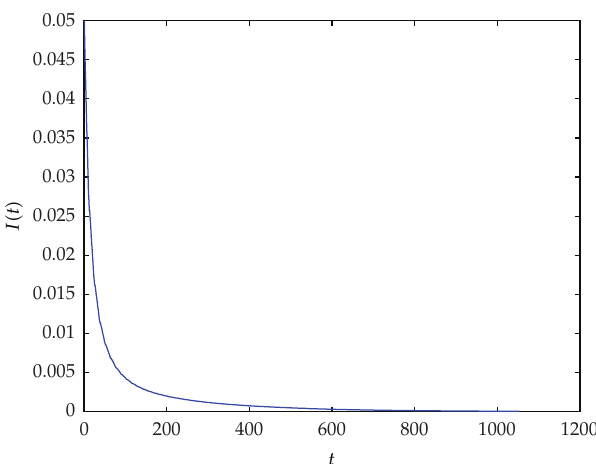
Figure 14: Time series of I (cid:3) t (cid:4) with parameters ρ (cid:7) 0 . 4 , μ (cid:7) 0 . 1 , β (cid:7) 1 , α (cid:7) 1 , r (cid:7) 0 . 3 , d (cid:7) 0 . 2 , ω (cid:7) 0 . 2 , T (cid:7) 0 . 8 , and τ (cid:7) 0 . 2.